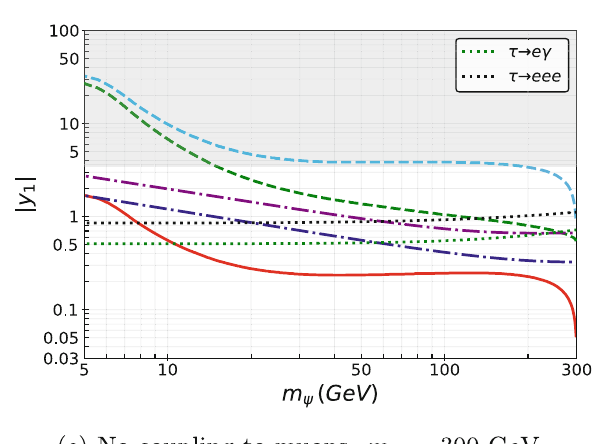
annihilations mediated by the scalar S are shown as dot-dashed navy blue (purple) line for Dirac (Majorana) dark matter. The dotted lines indicateconstraintsfromtherelevantLFVprocesses.Inthegrayshaded region the Yukawa coupling is non-perturbative, | y 1 | >